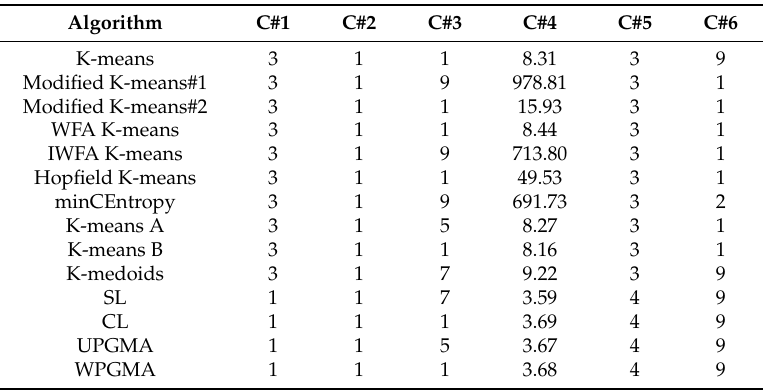
Table 13. Decision